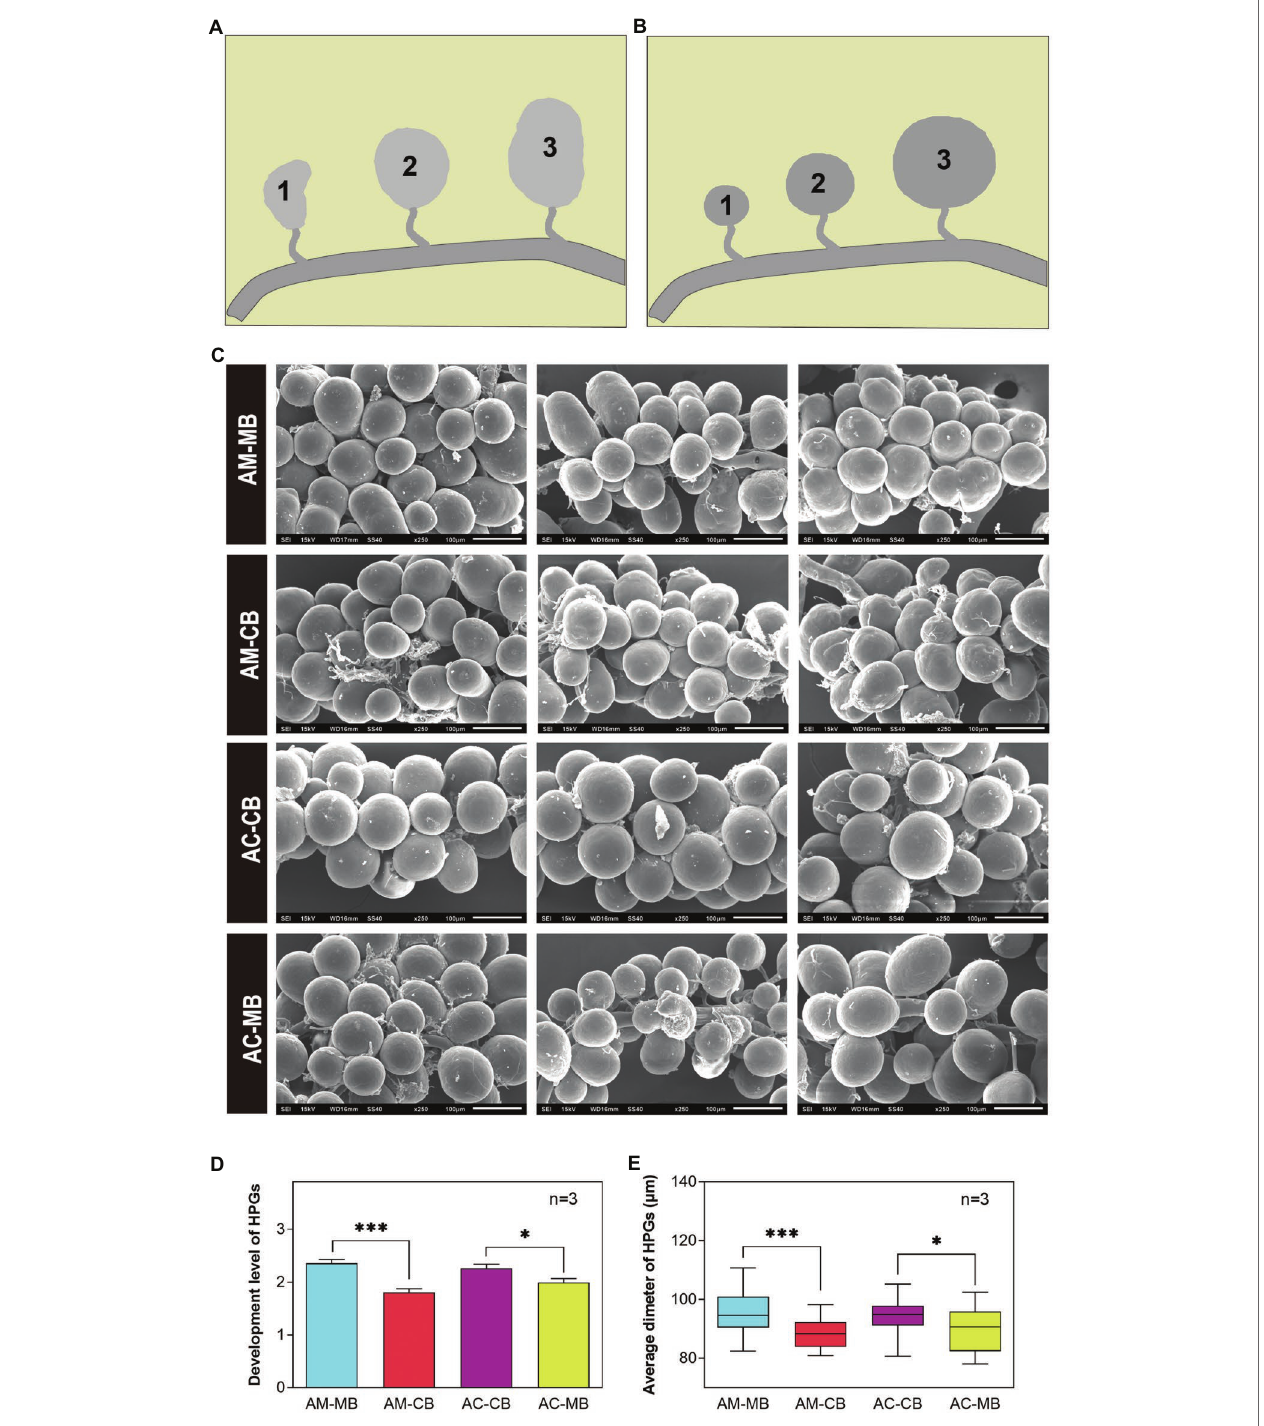
FIGURE 5 | The morphology and development of hypopharyngeal glands (HPGs) among Apis mellifera and Apis cerana bees. (A) Morphology of HPGs under different treatments (SEM, ×250). (B,C) The development grading levels of Apis mellifera (B) and Apis cerana (C) bees, respectively. Level 1: The development of HPG is small and withered; Level 2: The development of HPG is moderately developed and plump; Level 3: The development of HPG is fully developed and plump. (D,E) Comparison of the development degree (D) and average sizes (E) of HPGs between Apis mellifera and Apis cerana bees. Values are means ± SME. * p < 0.05, ** p < 0.01, and *** p < 0.001 by independent samples t